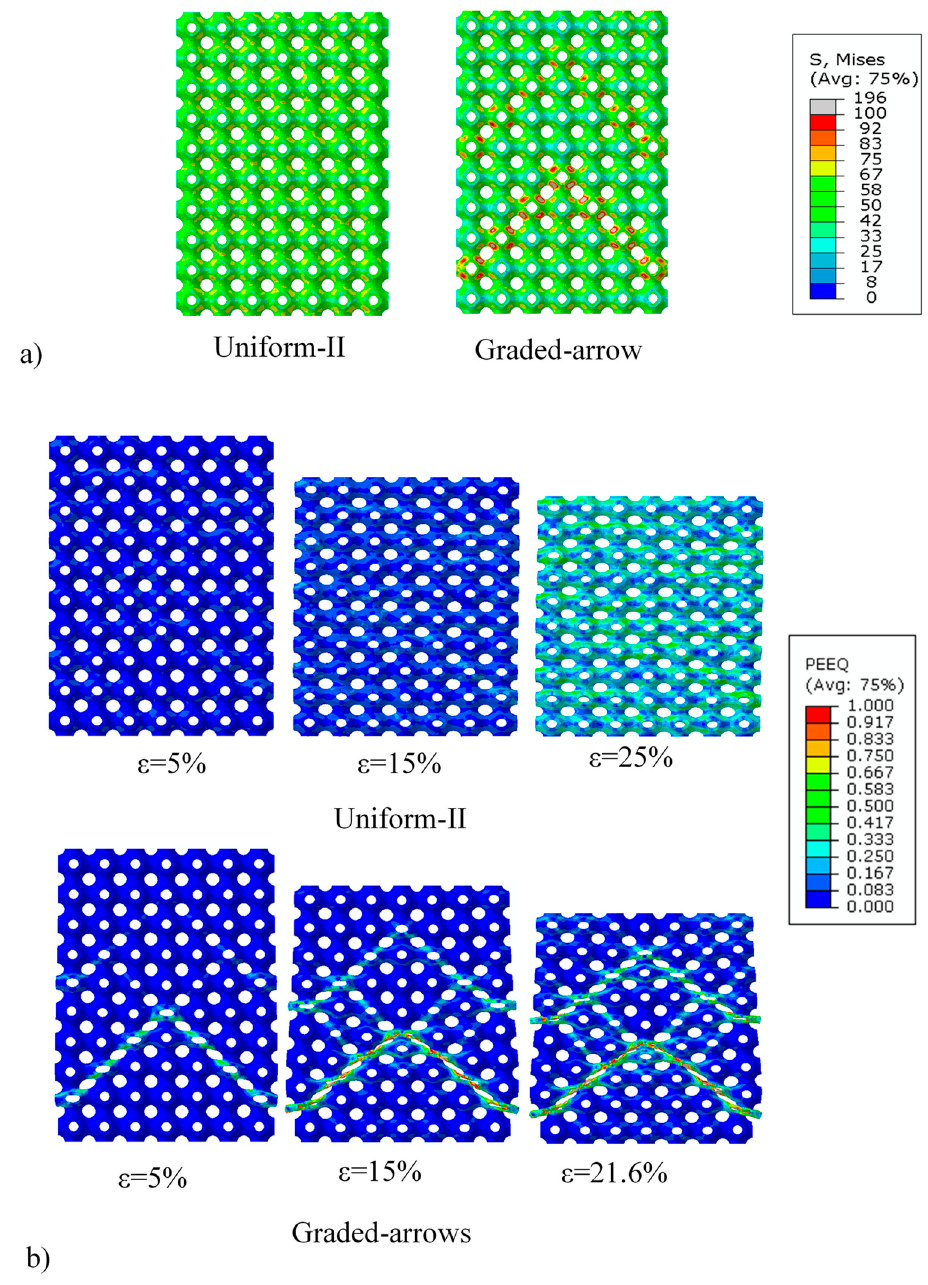
Figure 9. ( a ) The von Mises stress distribution and ( b ) equivalent plastic strain for the Uniform–II and graded ‐ arrows